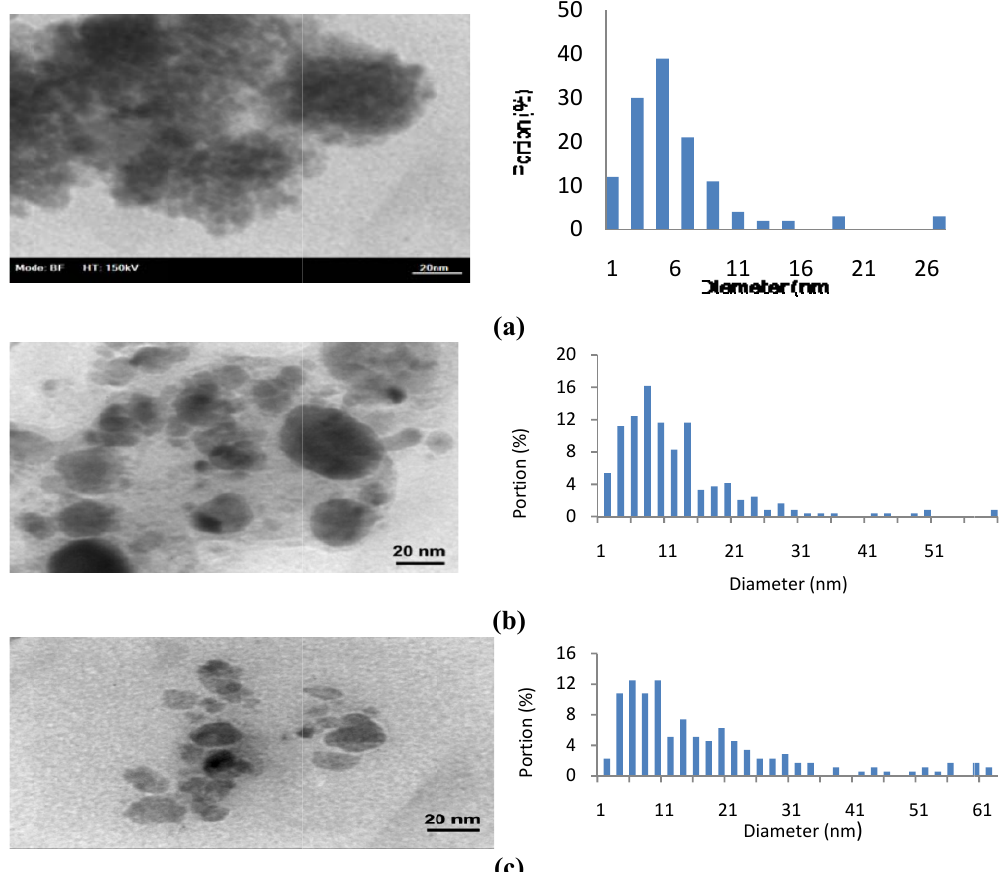
g.11: TEM image and plosion proc cess the